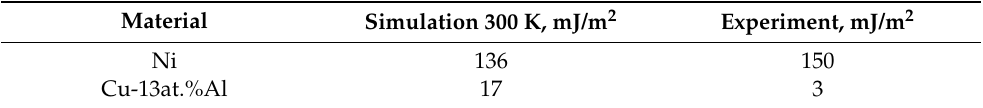
Figure 1. ( a ) Initial structure of the simulated sample and ( b ) the crystallographic diagram. Table 1. Calculated and experimental values of stacking fault energy.